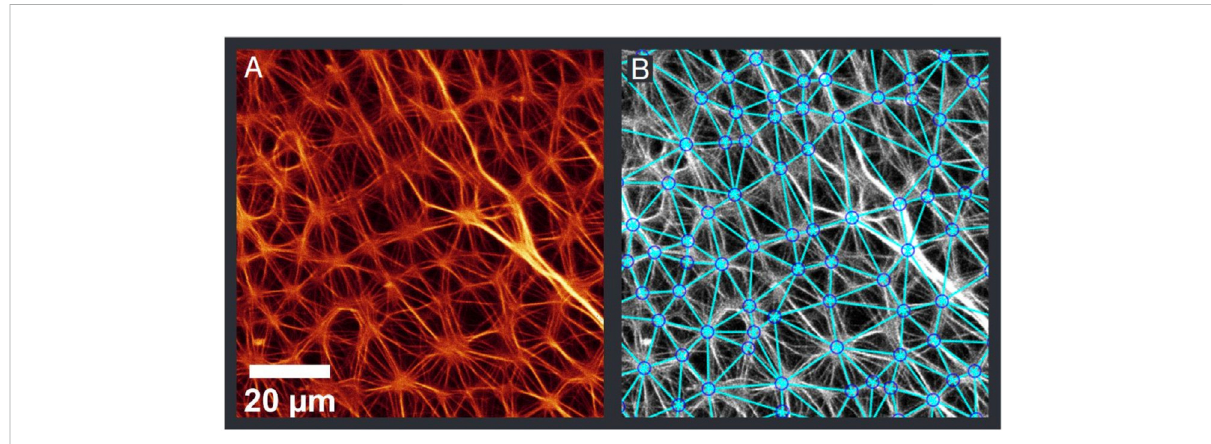
FIGURE 4 Original image (A) and detected aster vertexes (B) . The detection was performed with automated image analysis routines. The determined points were then connected with a Delaunay triangulation. Further analysis as seen in Figure 5 was done on the basis of the detected points.